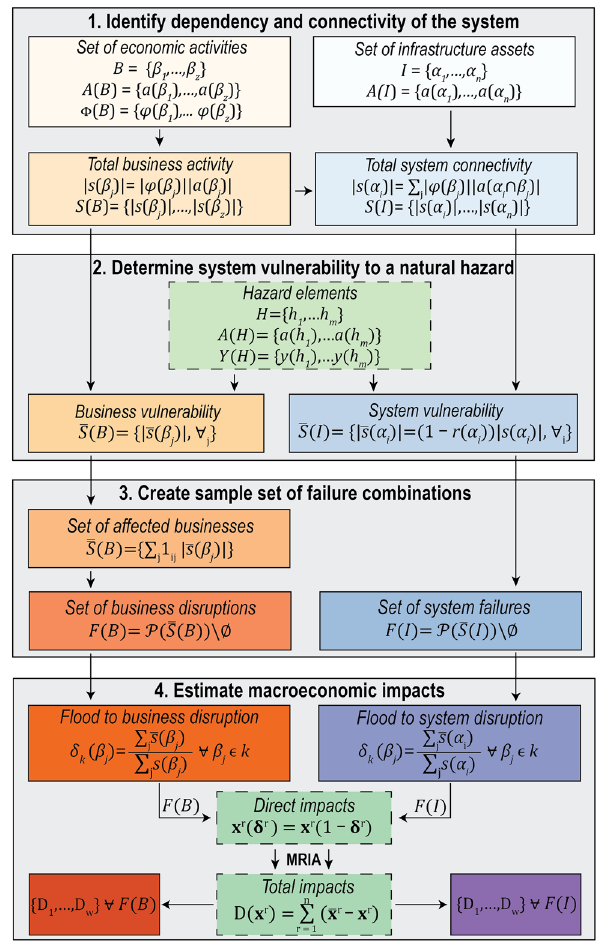
Fig. 2 Generalized framework of our approach. The model assesses the economic impacts of disruptions from natural hazards for two loss estimation approaches: (1) considering business disruptions in the area affected by the natural hazard only (left pillar—orange–red color scheme); and (2) considering systemic impacts of business disruptions and infrastructure failures, both within and external to the natural hazard area (right pillar—purple color